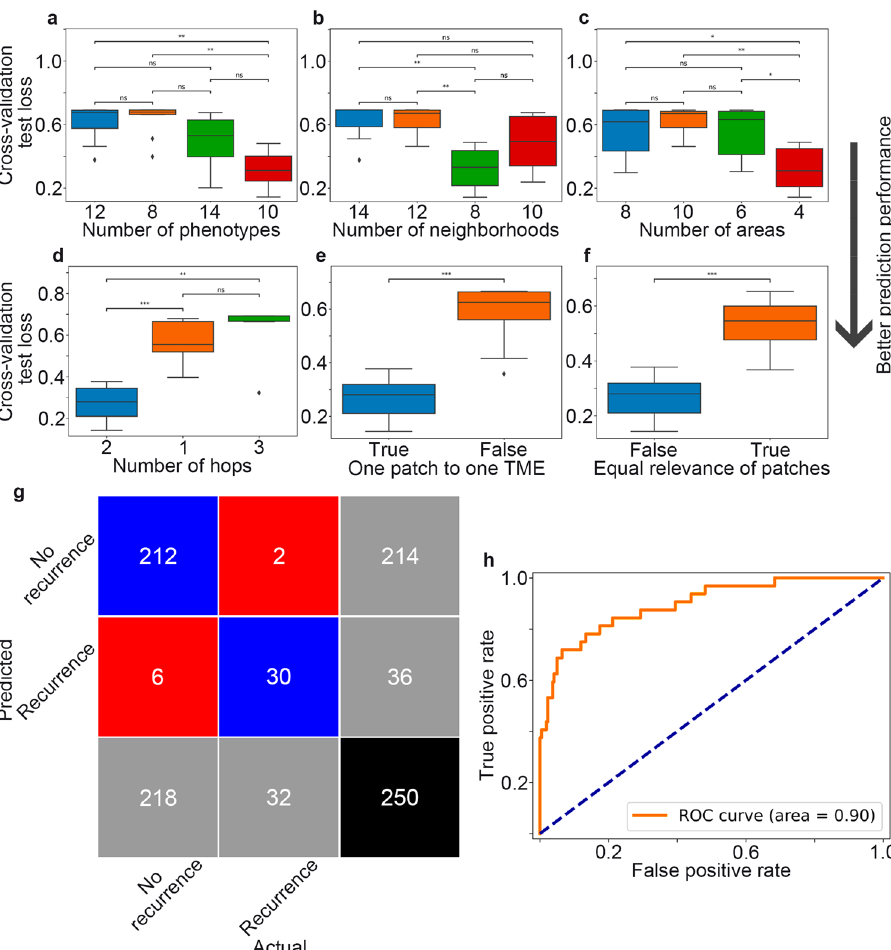
Fig. 2 Evaluation of model performance. a – c Optimal number of local phenotypes, cellular neighborhoods, and tissue areas for patient classi fi cation. NaroNet had a better performance (lower cross-validation test loss) when set up to identify ten local phenotypes, eight cellular neighborhoods, and four tissue areas. d Optimal number of hops (levels of depth) used by the graph neural network for assigning patches to cellular neighborhoods. Two hops were selected to identify cellular neighborhoods (each patch was assigned to a cellular neighborhood based on its own embedding and those of its 12 closest neighbors) e NaroNet performed better when patches were constrained to be assigned to one tumor microenvironmental element (TME) only. f Every image patch had the same relevance in the classi fi cation process. g , h Confusion matrix and area under the curve of the receiver operating characteristic curve (AUC ROC) for predicting tumor recurrence in EC using a tenfold cross-validation strategy. Data were analyzed using a two-sided Mann – Whitney – Wilcoxon test with Bonferroni correction. *, **, ***: P < 0.05 values considered statistically signi fi cant. ns statistically non-signi fi